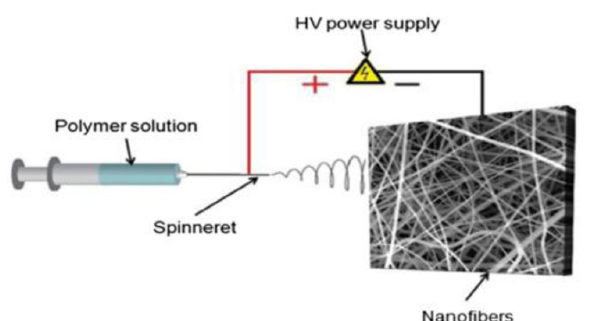
Figure 1: Diagram of electrospinning